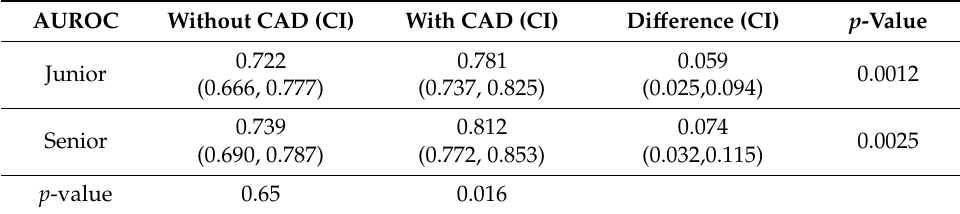
Table 4. The average AUROC of the junior group and the senior